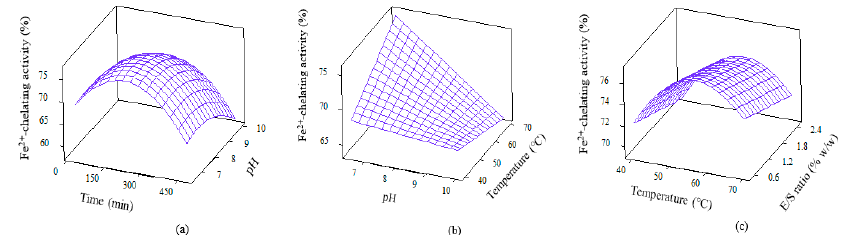
Figure 5. 3D surface plots for ferrous chelating activity as affected by ( a ) Time and pH; ( b ) pH and temperature and ( c ) Temperature and E/S ratio. temperature and ( c ) Temperature and E / S ratio.